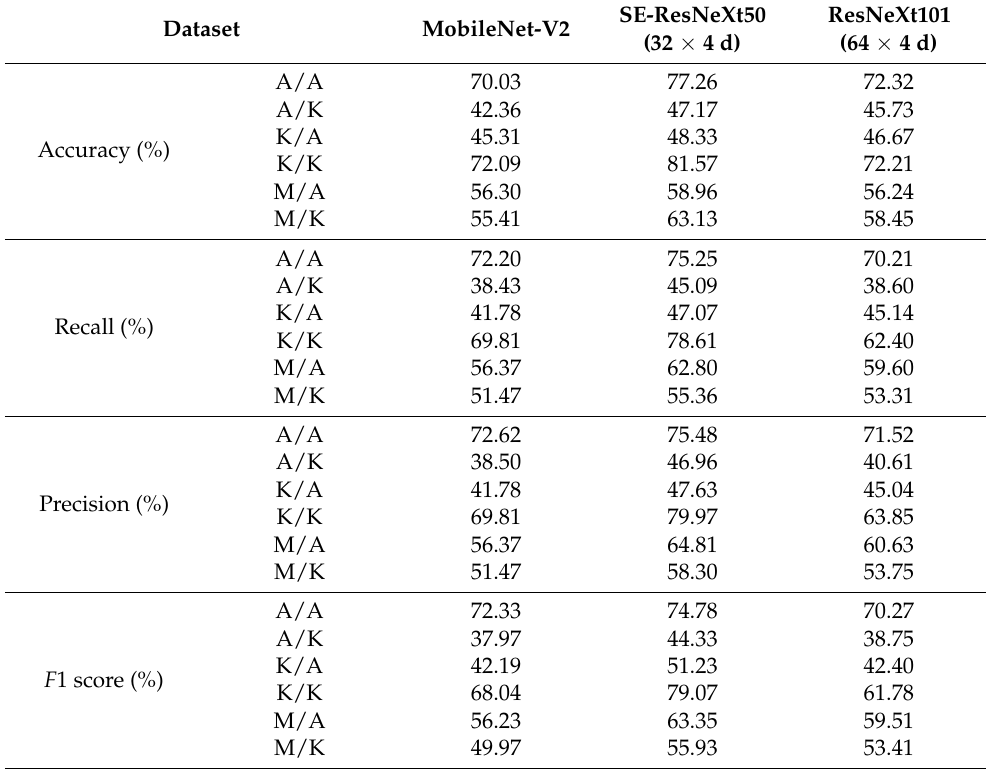
Figure 4. Emotion recognition accuracy by the architecture type. Table 3. Deviation between the three age-specific, opposite-age, and mixed-age architectures.